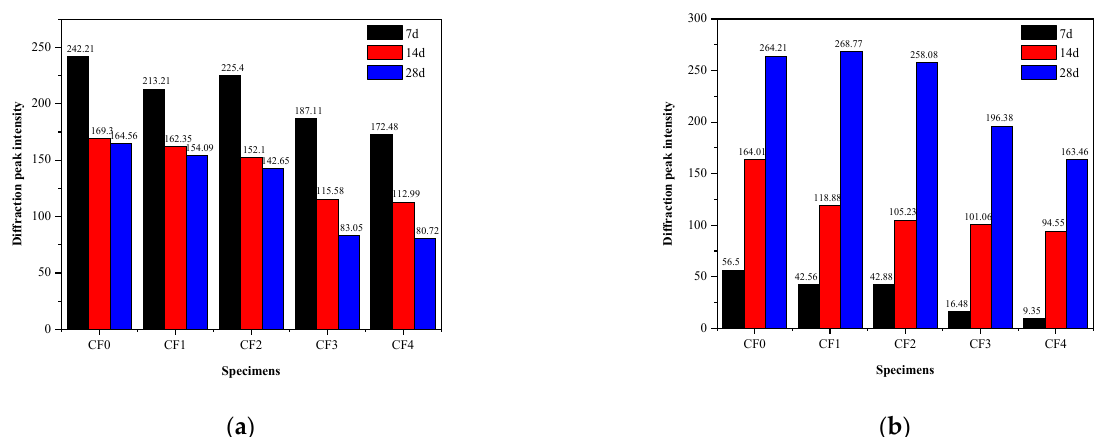
Figure 9. ( a ) C 2 S and C 3 S and ( b ) C-S-H peak intensity of fly-ash-modified CSM with 100% RMA at different ages.